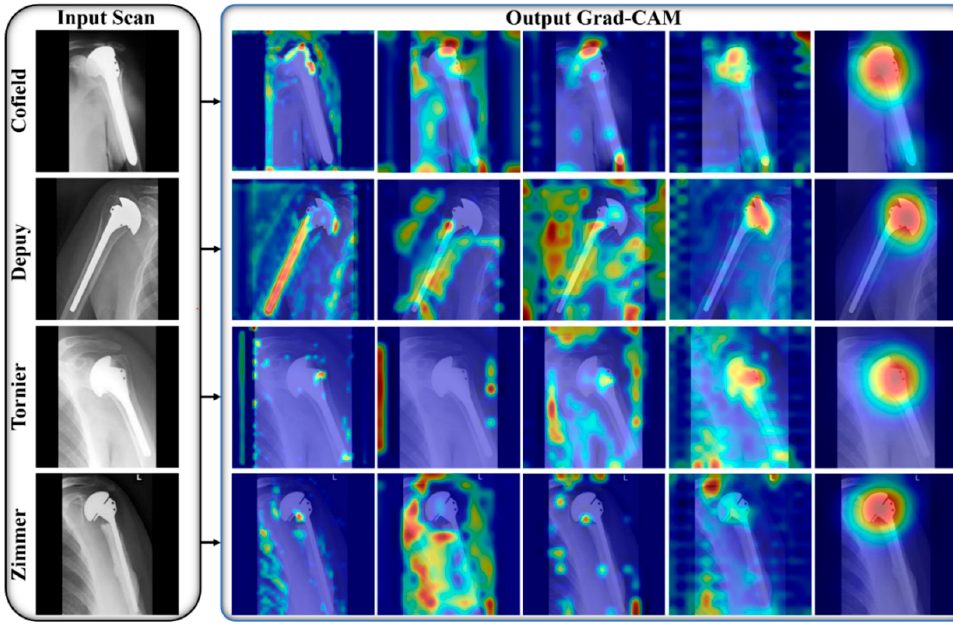
Figure 5. Visual explanation maps of IFC-Net for all manufacturers. The 1st to 5th Grad-CAM images are, respectively, obtained from Block A, Block B, Block C, Block D, and Block E in Table S2.